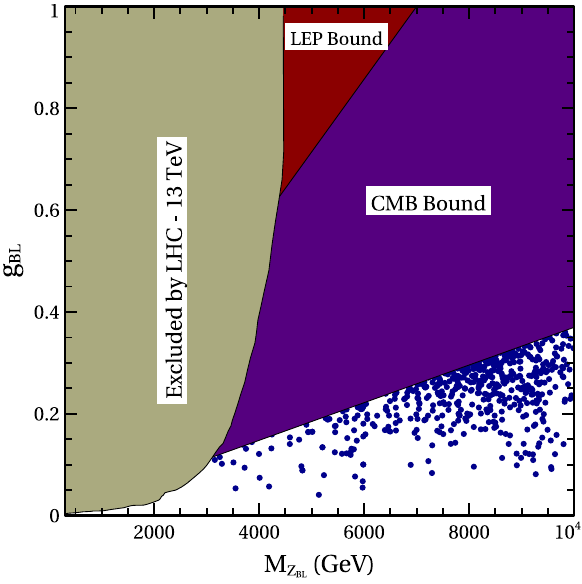
Fig. 4 Summary plot showing allowed parameter space of the model from all relevant experiments and observations